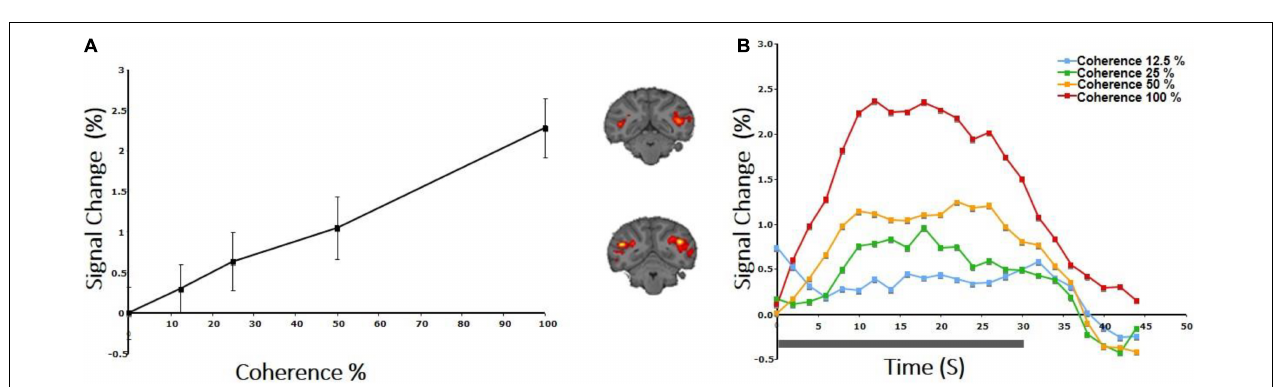
FIGURE 4 | CBV response to coherence in the area V5/MT+ of a rhesus macaque. (A) Both area V5/MT and MST behaved in a similar manner and are grouped together. Note the monotonic increase of the CBV signal as a function of coherence. (B) BOLD signal intensity modulation induced by presenting an RDK with motion coherence levels: 12.5, 25, 50, 100%. Transition from the baseline (0% coherence) occurred at time 0, and the duration of the coherent RDK presentation was 30 s.